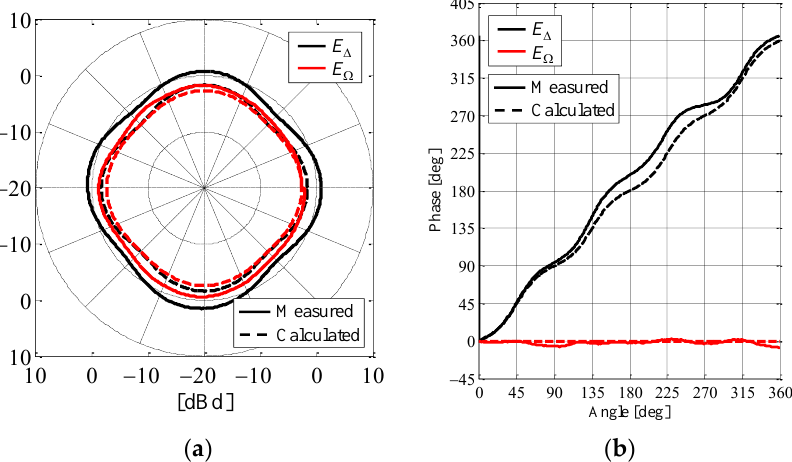
Figure 14. Measured complex directivity for the AOA estimation function: ( a ) amplitude and ( b ) phase.